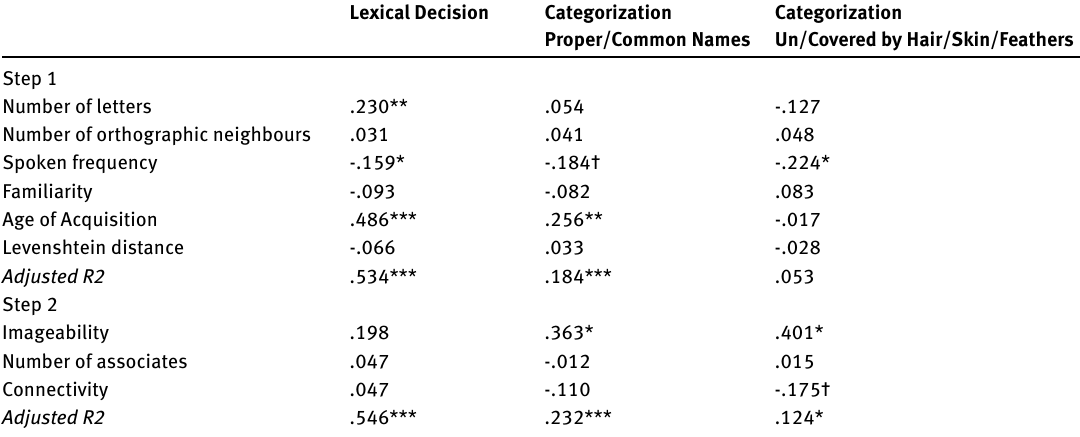
Table 4: Standardized regression coefficients (β) for four hierarchical regression analyses carried out on lexical decision and categorization times